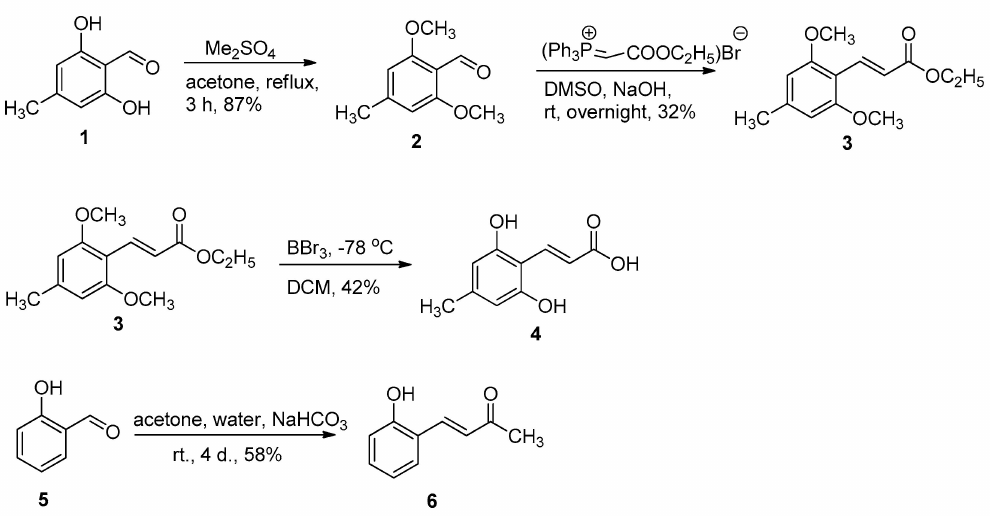
Scheme 1. Examples of caffeic acid analogues’